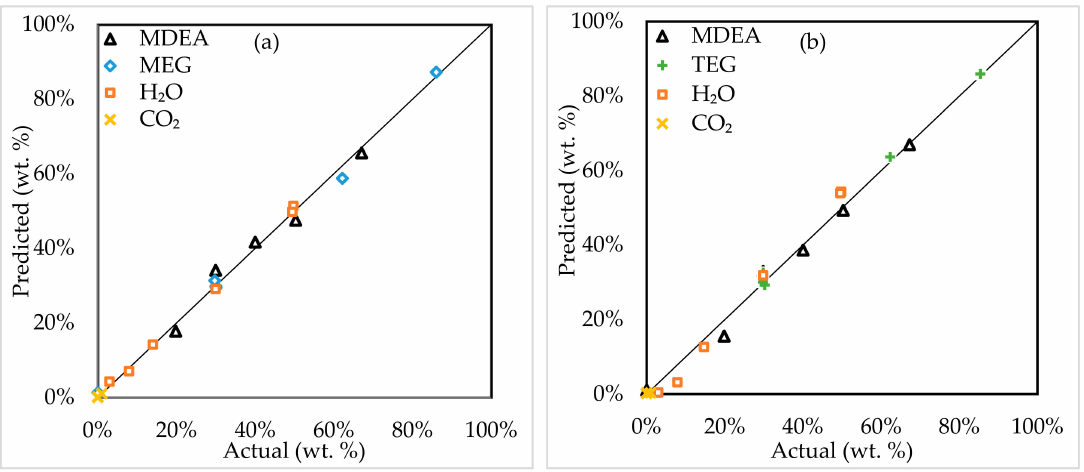
Figure 9. Validation with left-out spectra; the MDEA-MEG-H 2 O-CO 2 system ( a ) and MDEA-TEG-H 2 O-CO 2 system ( b